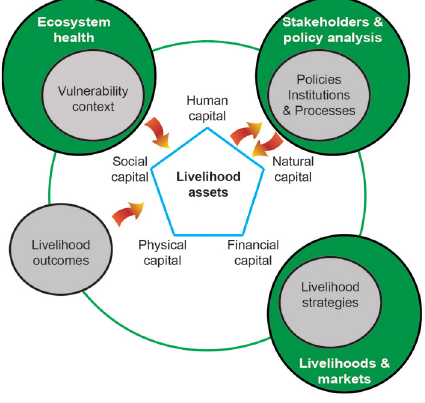
Figure 2. The sustainable livelihoods approach as applied to this